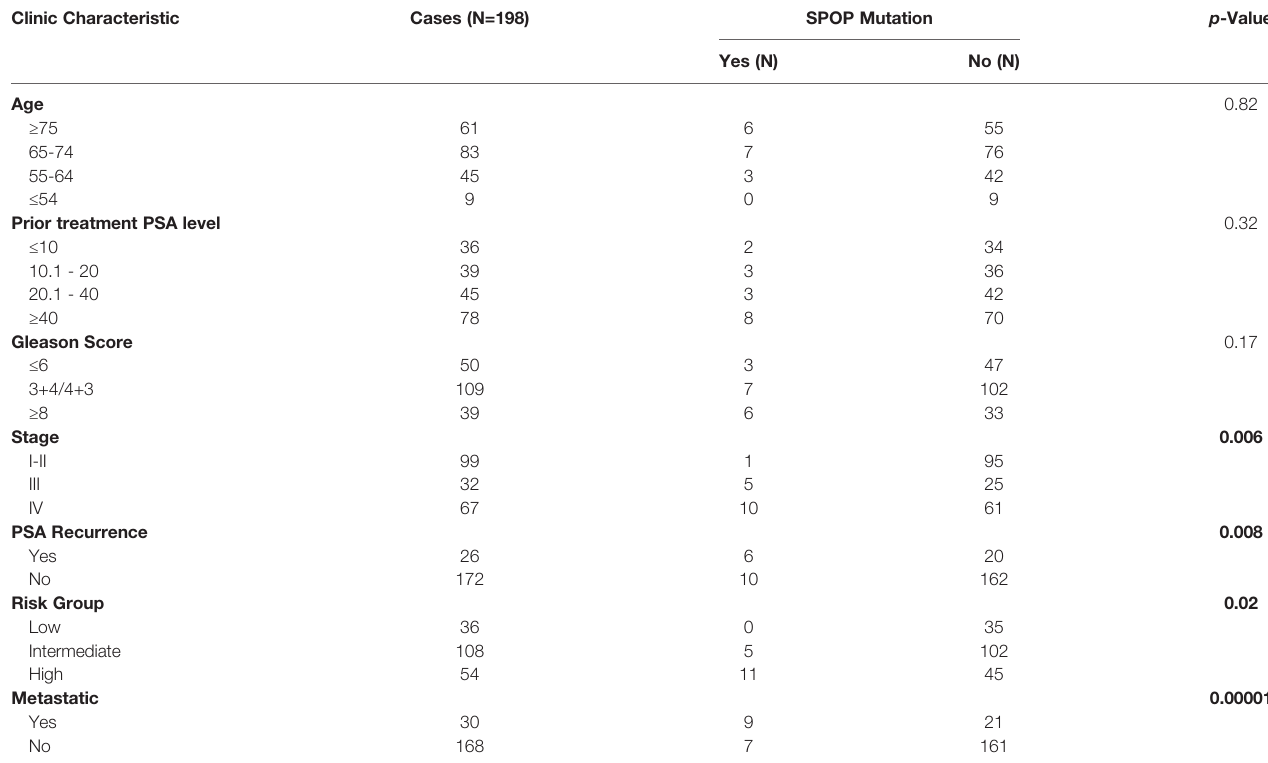
Bold values mean the p-values <